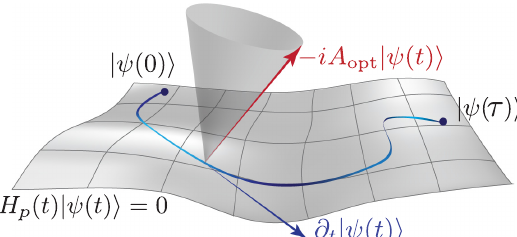
FIG. 1. Schematic representation of the desired trajectory | ψ( t ) (cid:2) connecting two points | ψ( 0 ) (cid:2) and | ψ(τ) (cid:2) within the MPS manifold (cid:2) . For the MPS manifold, one can define a family of parent Hamiltonians H p ( t ) that have a state | ψ( t ) (cid:2) as their